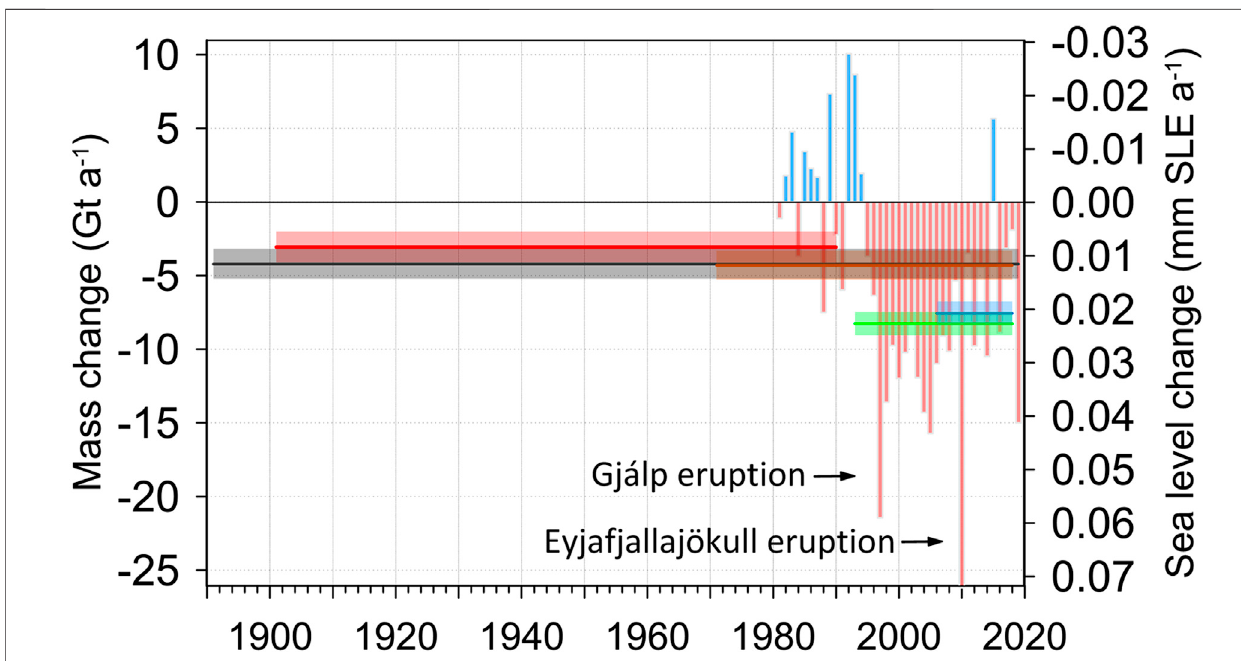
FIGURE5| ThemasschangesofallglaciersinIcelandasestimatedfromthedatapresentedin Figure3 ,showingannualvaluesfortheperiod1980/81to2018/19 and average mass loss rates for the fi ve periods; 1890/91 – 2018/19 (black), 1900/01 – 1989/90 (red), 1970/71 – 2017/18 (orange), 1992/93 – 2017/18 (green), and 2005/ 06 – 2017/18 (blue). The two pronounced extremes in 1996/97 and 2009/10 show the melting of ∼ 3.7 Gt of ice due to the Gjálp eruption (mid-Vatnajökull) in October